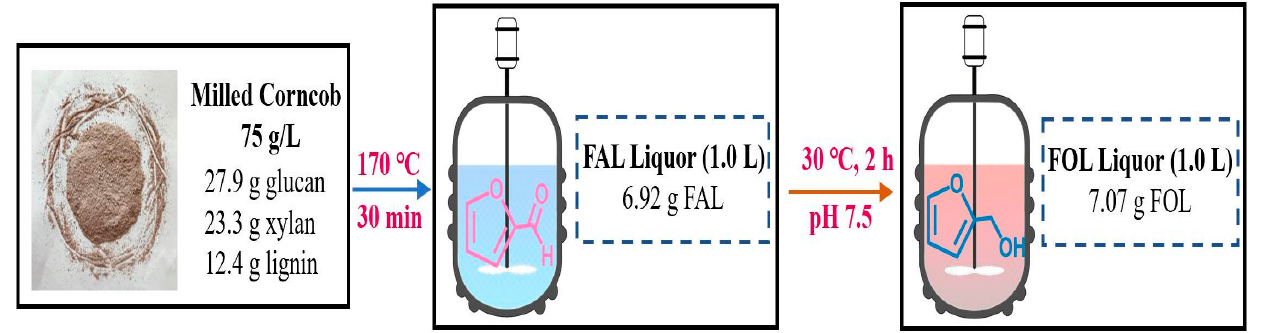
Table 2. Examples of transforming FAL into FOL with the biocatalyst.